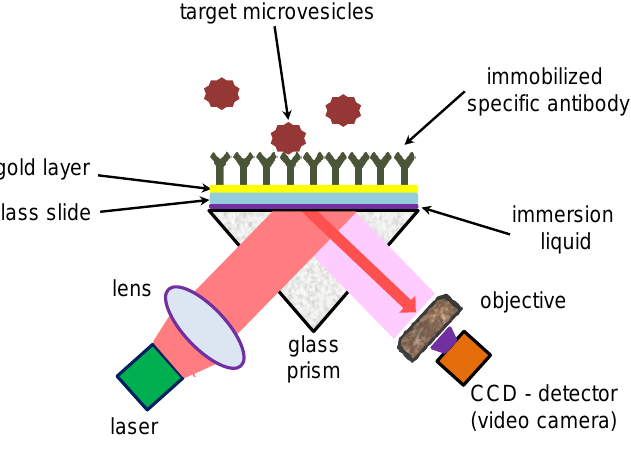
Figure 1. Scheme of PAMONO-sensor experimental setup used for detection of biological